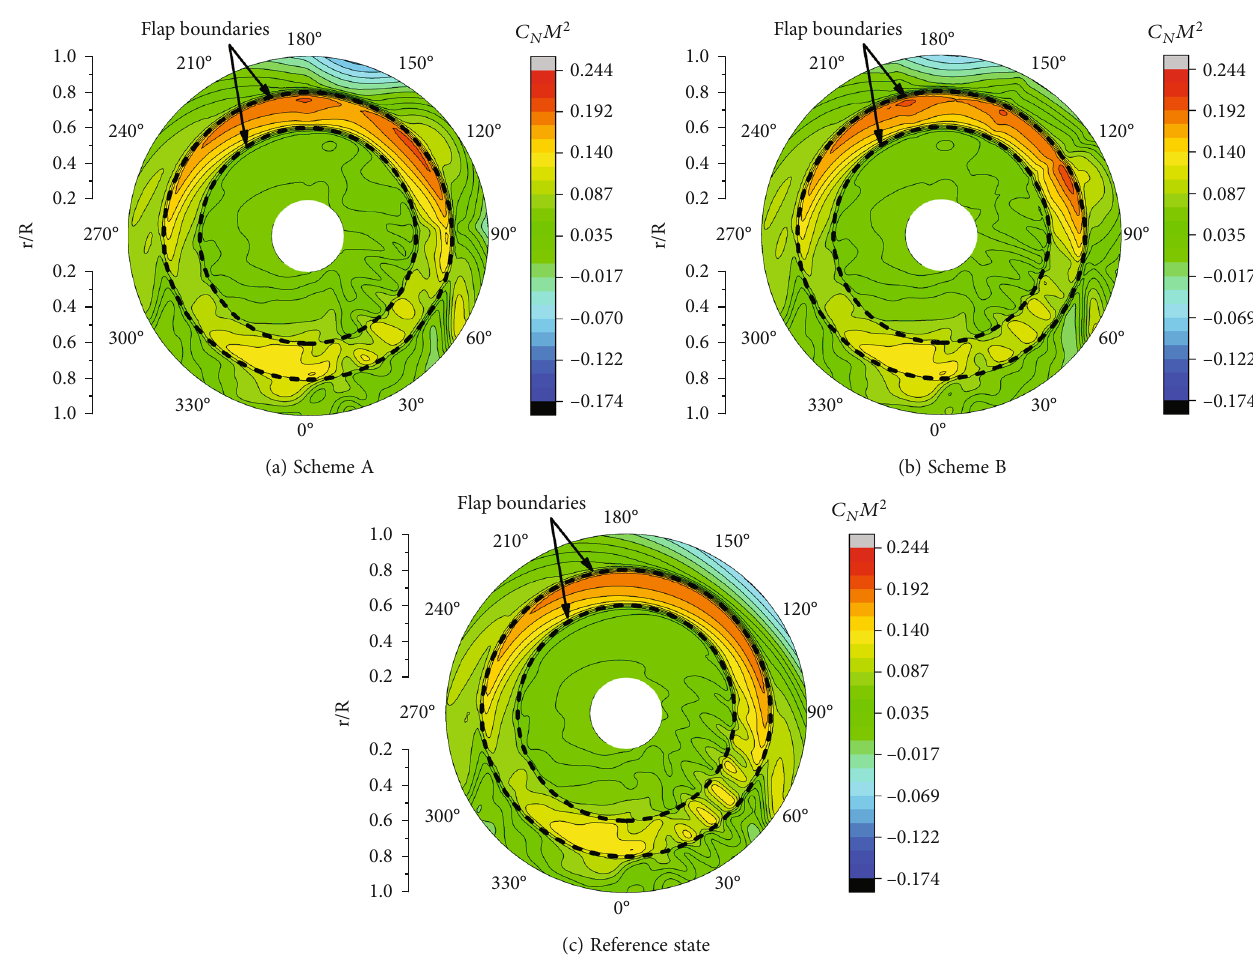
Figure 13: E ff ect of fl ap nonharmonic input on the load of ECR disc (input amplitude = − 5 ° ).